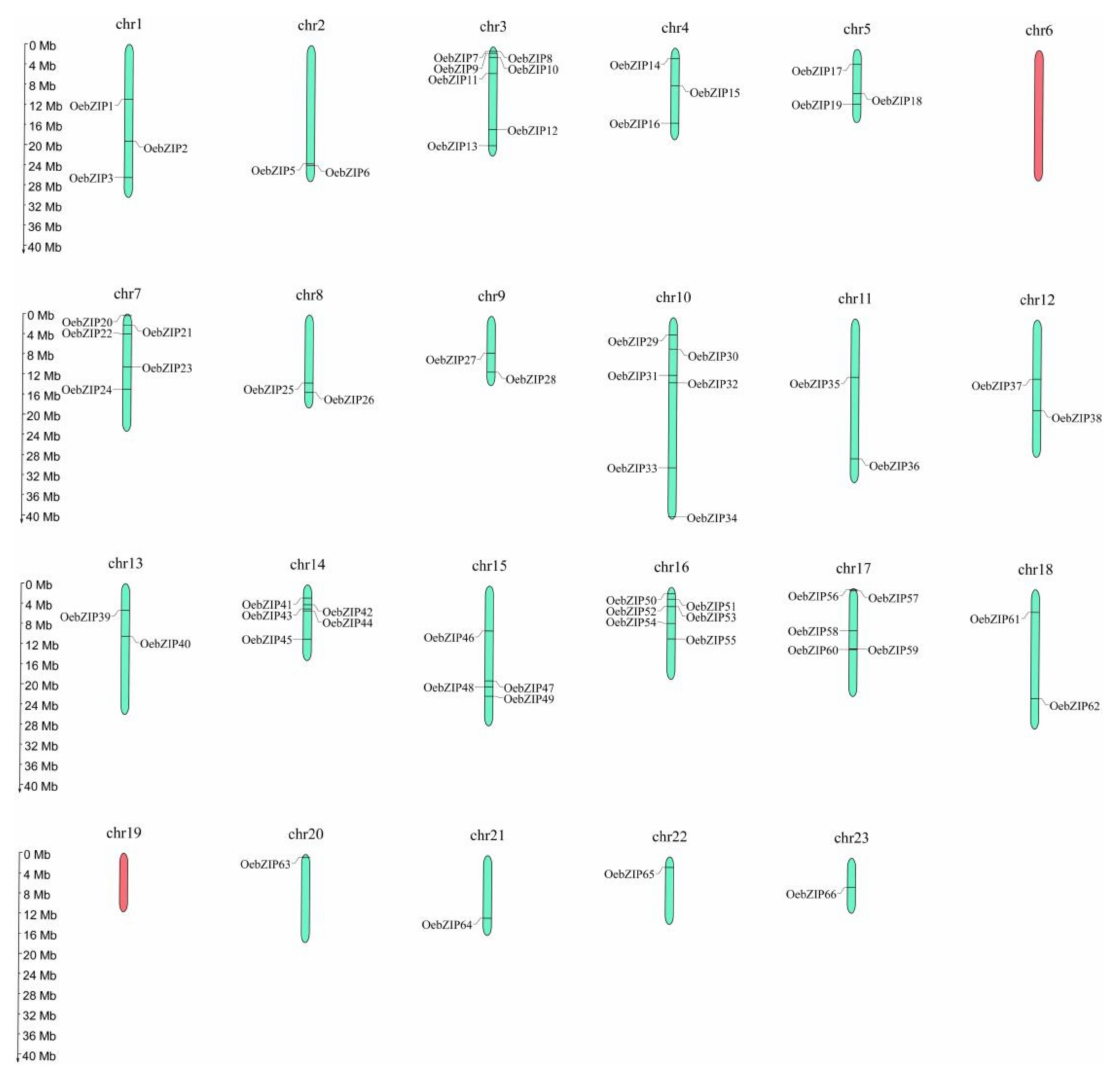
Figure 3. The distribution of bZIP genes on olive chromosomes. The red color represents chromosomes without OebZIP genes and the green is the chromosome that has OebZIP genes. The relative length of the chromosomes is millions of base pairs